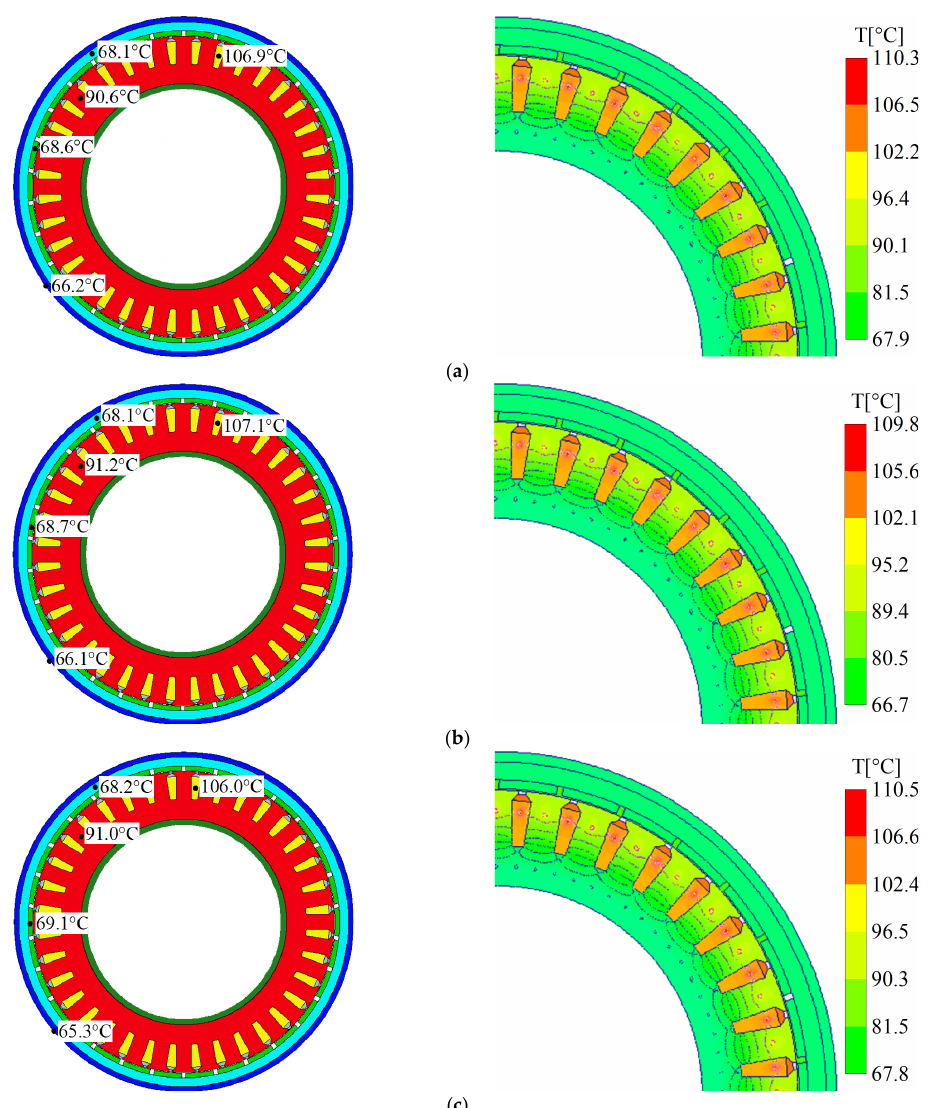
Figure 13. Temperature distribution map of candidate points. ( a ) Candidate point 1; ( b ) candidate point 2; ( c ) candidate point 3.